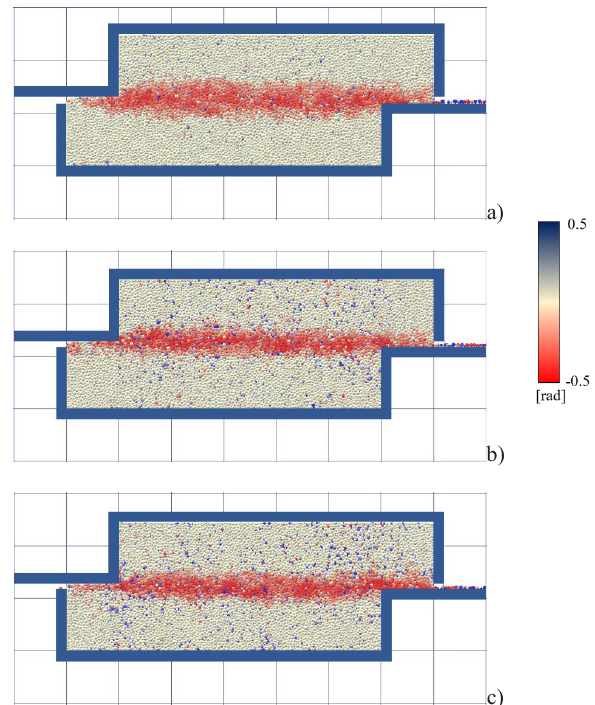
Figure 18: Distribution of sphere rotations at the final state of the test for different vertical load: a) σ = 50 kPa, b) σ = 200 kPa and 0 0 c) σ = 500 kPa ( e = 0.60, d = 0.5 mm) (red colour – clockwise 0 0 50 rotations, blue colour – anti-clockwise rotations) (colour